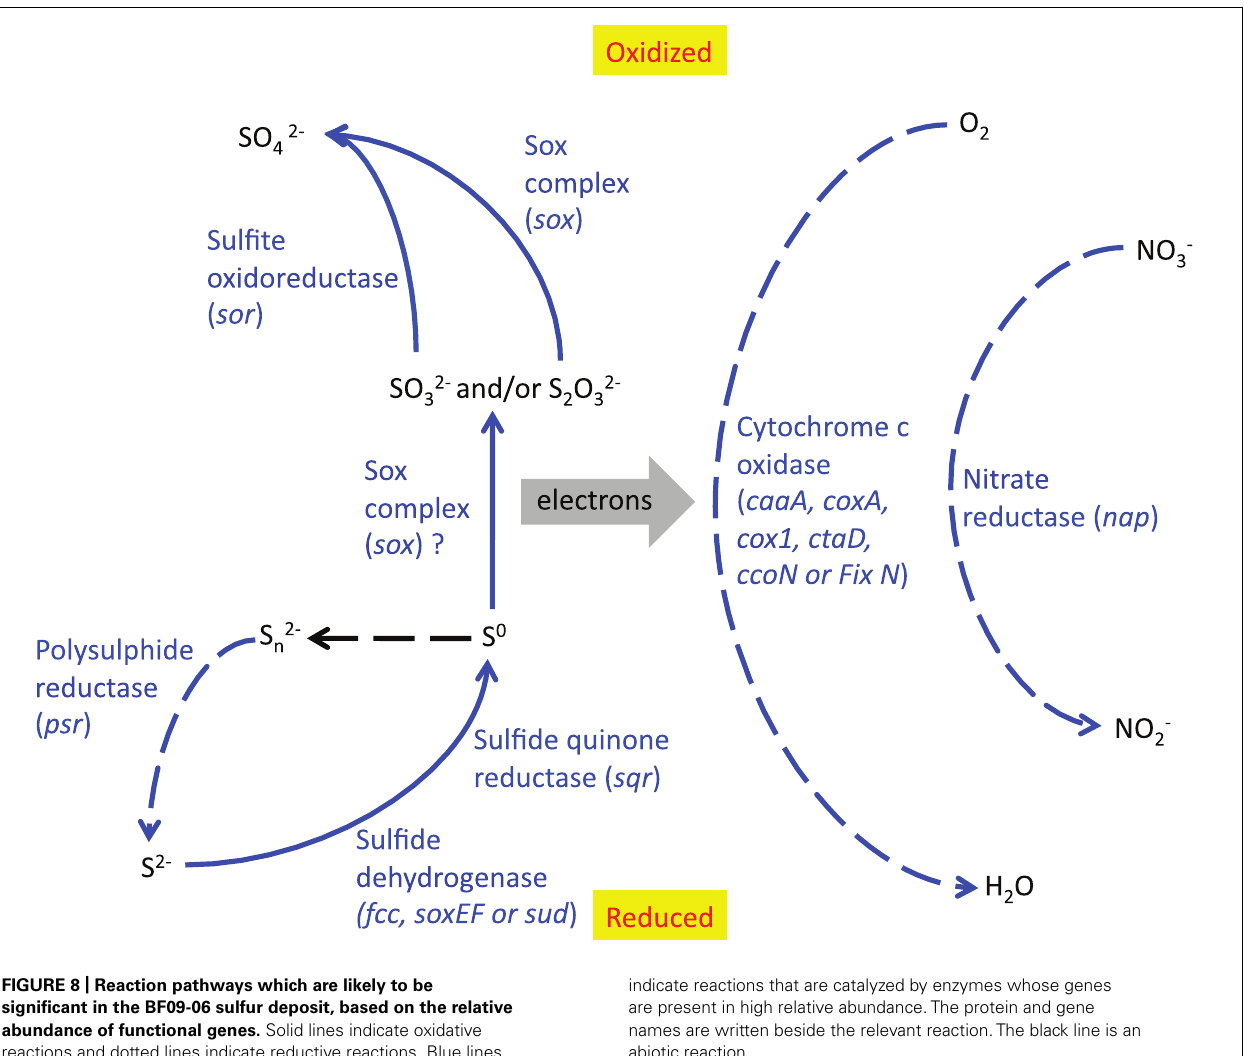
indicate reactions that are catalyzed by enzymes whose genes are present in high relative abundance.The protein and gene names are written beside the relevant reaction.The black line is an abiotic